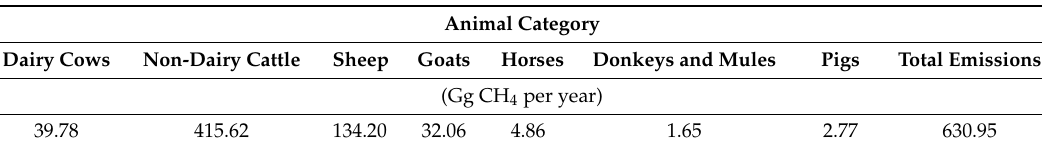
Table 3. South African average enteric methane emissions from 1990 to 2014 using 2006 IPCC default factors.